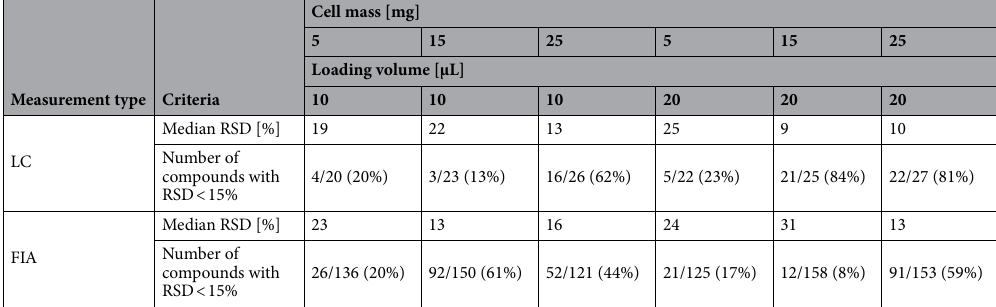
Table 2. The median relative standard deviation (RSD) of individual compounds in HOS cells and the percentage of detected compounds with RSD < 15% (in total and in % from detected number) as detected with the Biocrates p400 HR kit using either liquid chromatography (LC) for flow injection analysis (FIA) mass spectrometry. Five replicates were measured in each condition; outliers were removed from the final analysis as described in the materials and